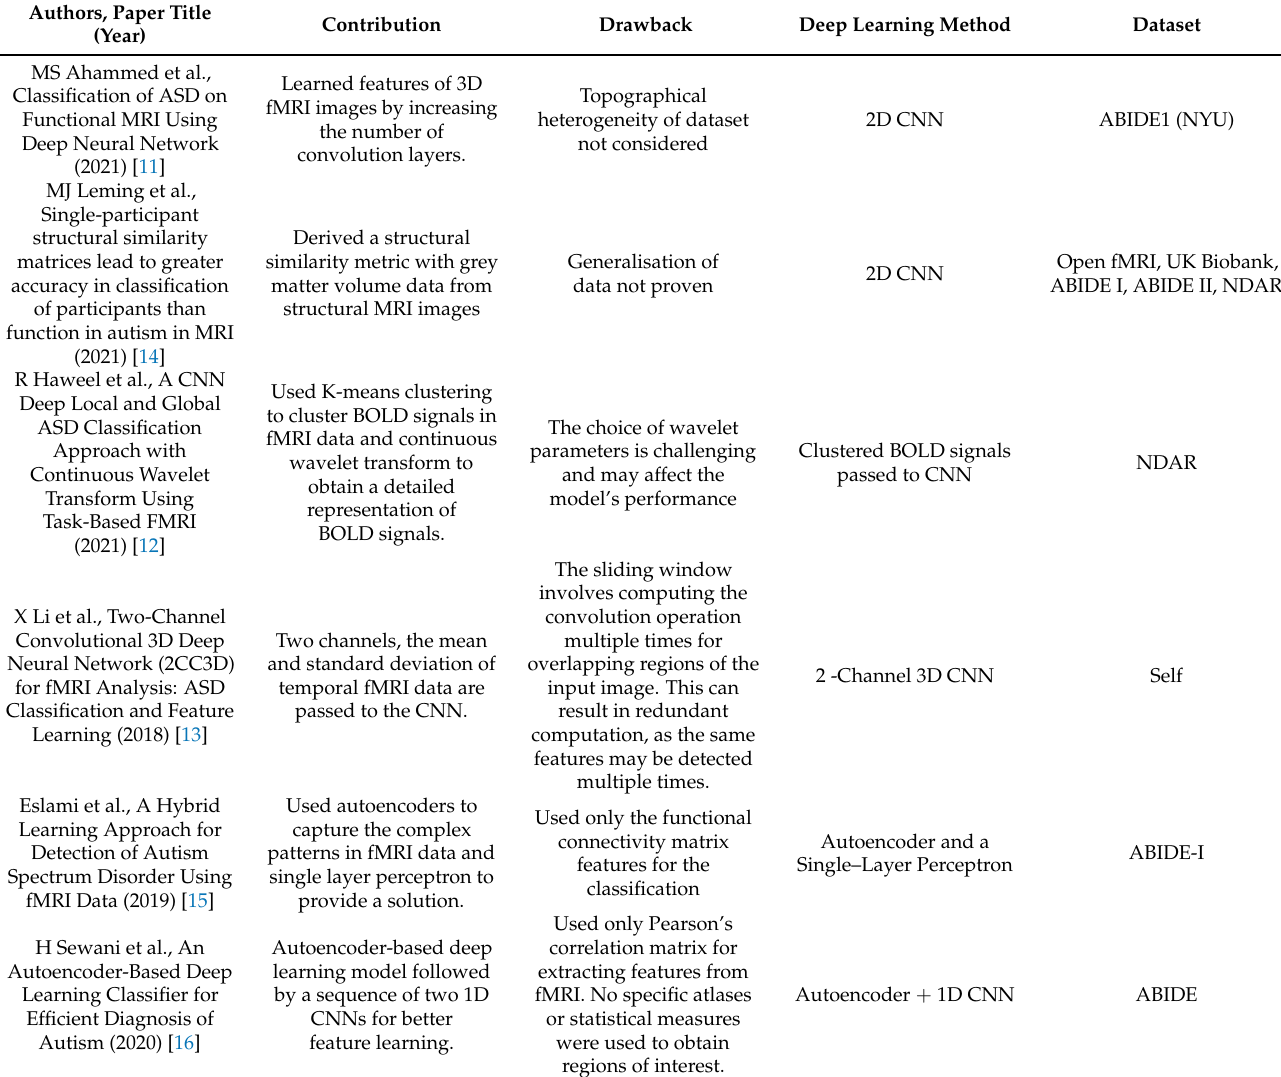
Table 1. Summary of Related